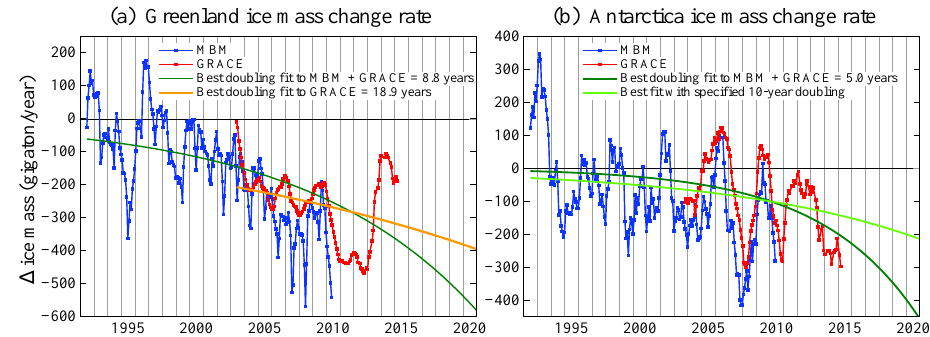
Figure 30. Greenland and Antarctic ice mass change. GRACE data are extension of Velicogna et al. (2014) gravity data. MBM (mass budget method) data are from Rignot et al. (2011). Red curves are gravity data for Greenland and Antarctica only; small Arctic ice caps and ice shelf melt add to freshwater